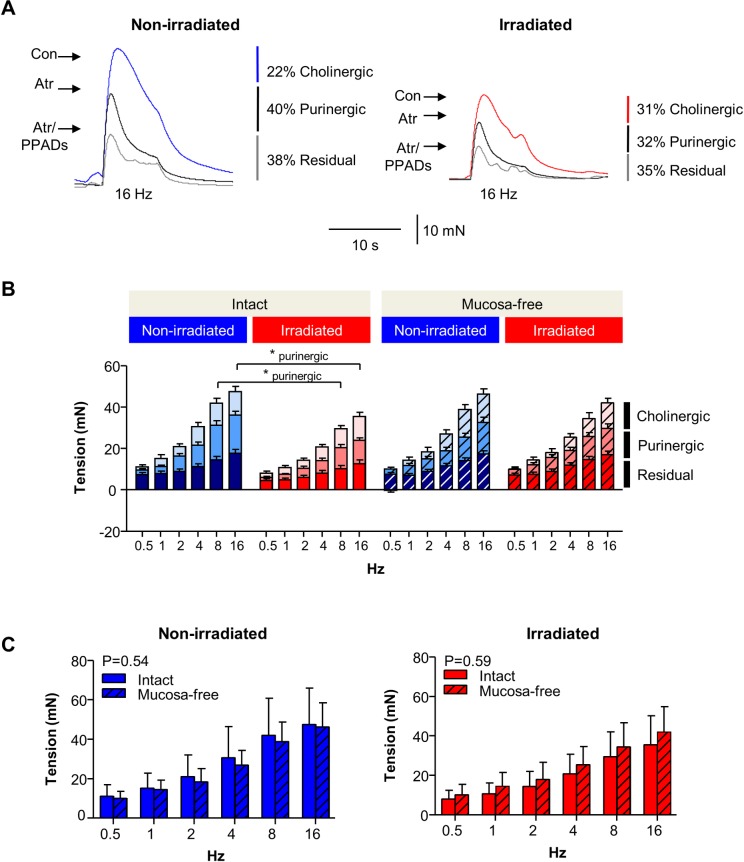
Comparison of cholinergic, purinergic and residual neurogenic contractions in non-irradiated and irradiated bladder strips.(A) Traces of neurogenic contractions (16Hz) on an expanded timescale from Fig 1 showing cholinergic, purinergic and residual components. Control (Con), atropine (Atr), Atr/PPADs (atropine and PPADs present). (B) Cholinergic, purinergic and residual components of neurogenic contractions were calculated from atropine-sensitive, PPADs-sensitive and atropine/PPADs-resistant neurogenic contractions in irradiated and non-irradiated, intact and mucosa-free bladder strips. The purinergic component of neurogenic contractions was reduced in irradiated intact strips, compared to non-irradiated (P<0.05). * denotes P<0.05. (C) Bar charts from data in Figs 1 and 2 showing that absence of the mucosal layer per se had no significant effect on the amplitude of neurogenic contractions in control tissues (P = 0.54, 2-way ANOVA with Bonferroni post-hoc test). Similar findings were obtained with irradiated tissues (P = 0.59).